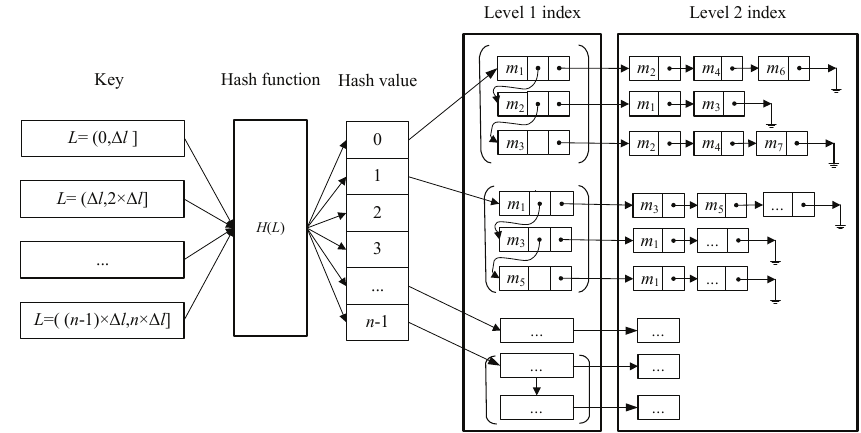
Figure 4. Building the two-level index hash table.